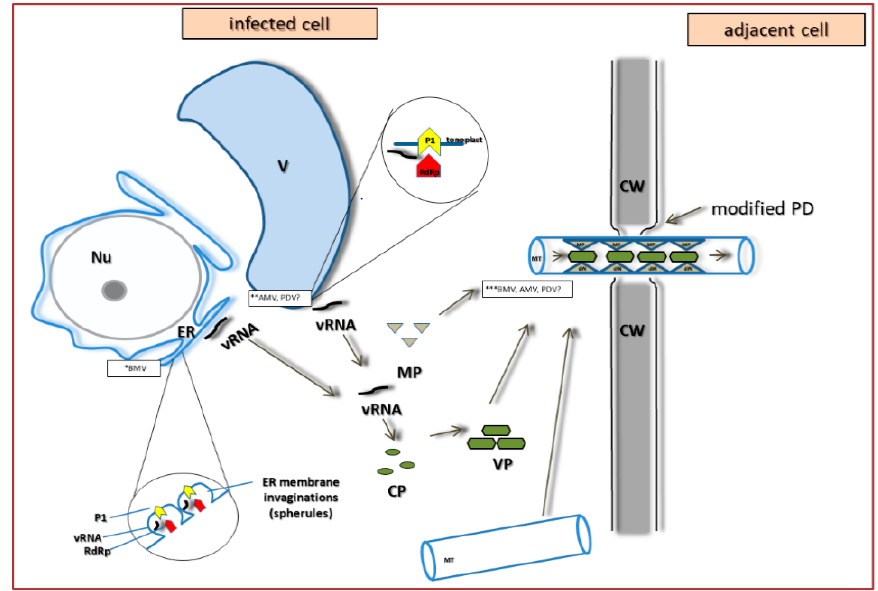
Figure 11. A model of PDV life cycle including replication and cell-to-cell transport, based upon research data for BMV and AMV. The BMV replication complex (P1 and P2) is assembled inside the spherules of the endoplasmic reticulum (ER) membranes. Viral RNA of BMV is encapsidated inside virion shells composed of CP molecules. In contrast, in the case of AMV and likely of PDV, the assembly of the replication complex and RNA replication are connected with the tonoplast membrane. As for BMV, the AMV and PDV RNAs are encapsidated with CP molecules. Thereafter, the assembled BMV or AMV (and likely PDV) virions are transported inside the microtubules (MT) that were modified with MP molecules. MP both change the PD size exclusion limit (SEL), but also destroy desmotubule structures inside PD. Frame with *BMV—replication sites of vRNA. Frame with **AMV, PDV replication sites of vRNA. Frame with ***BMV, AMV, PDV viral particles transported with help of MP an MT—in the case of PDV, probably route (mechanism) of cell-to-cell transport.